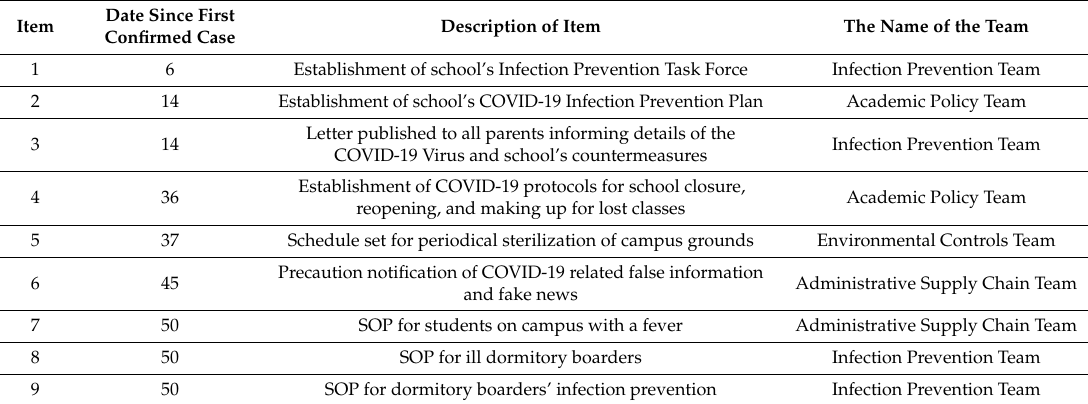
Table 2. Regulations, precautions, and standard operating procedures